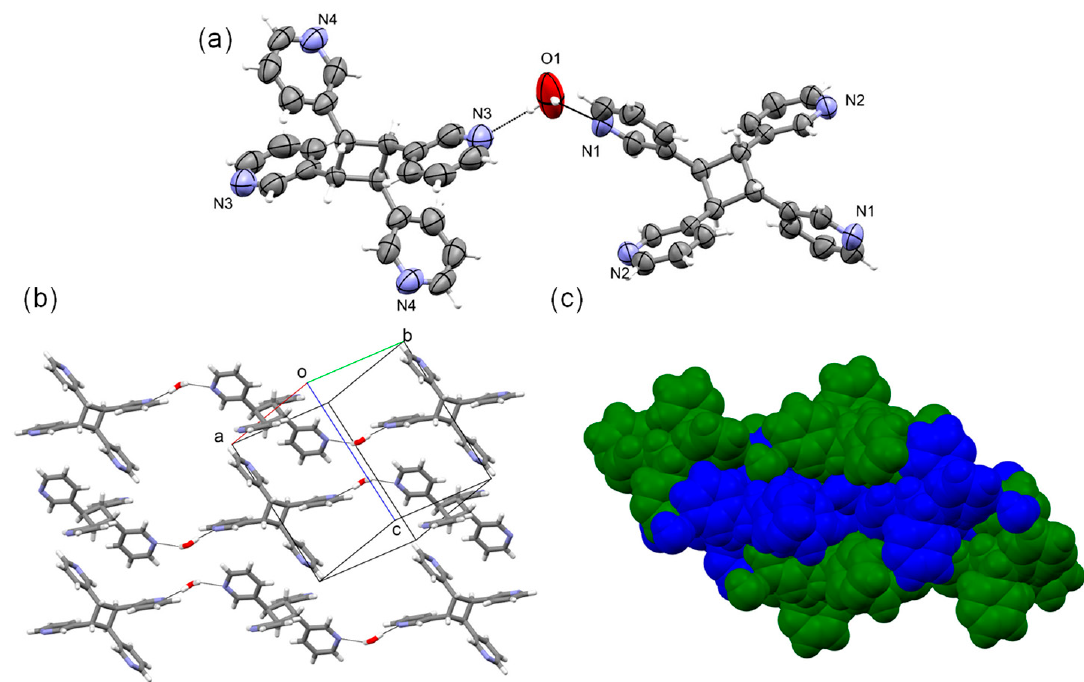
Figure 3. X-ray structure ( rctt - 3,3’-tpcb )·(H 2 O): ( a ) ORTEP representation; ( b ) 1D hydrogen-bonded chains ( c ) interdigitated 2D sheets with separate 2D sheets blue and green.